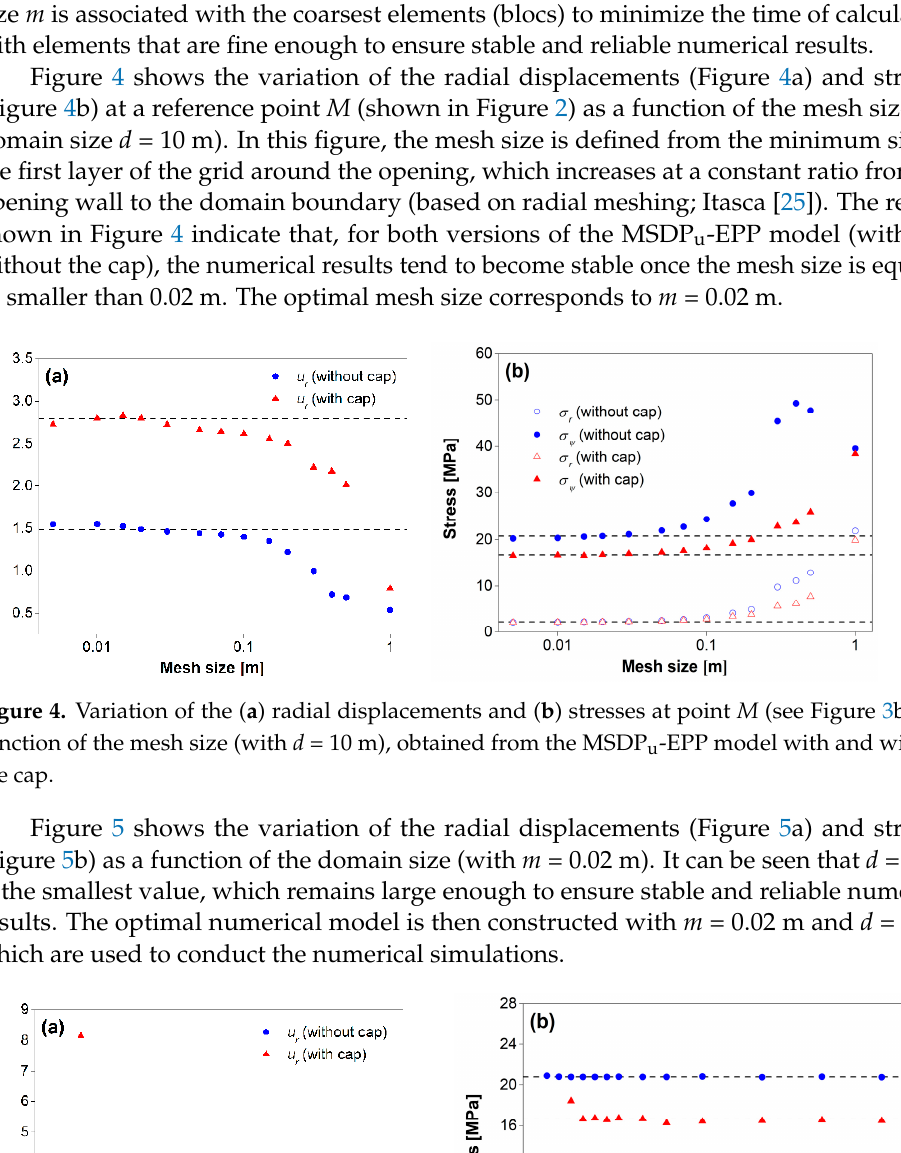
Figure 5. Variation of the ( a ) radial displacements and ( b ) stresses at point M (see Figure 3b) as a function of domain size (with m = 0.02 m) obtained from the MSDP u ‐ EPP model with and without the cap.